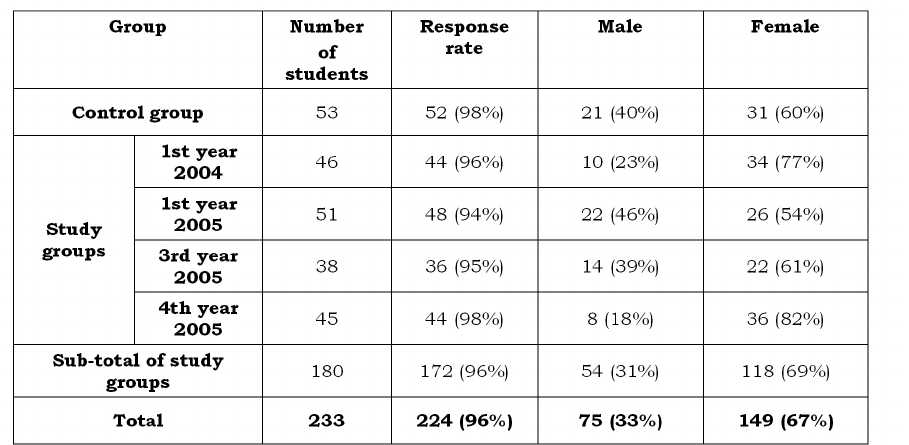
Gender distribution of